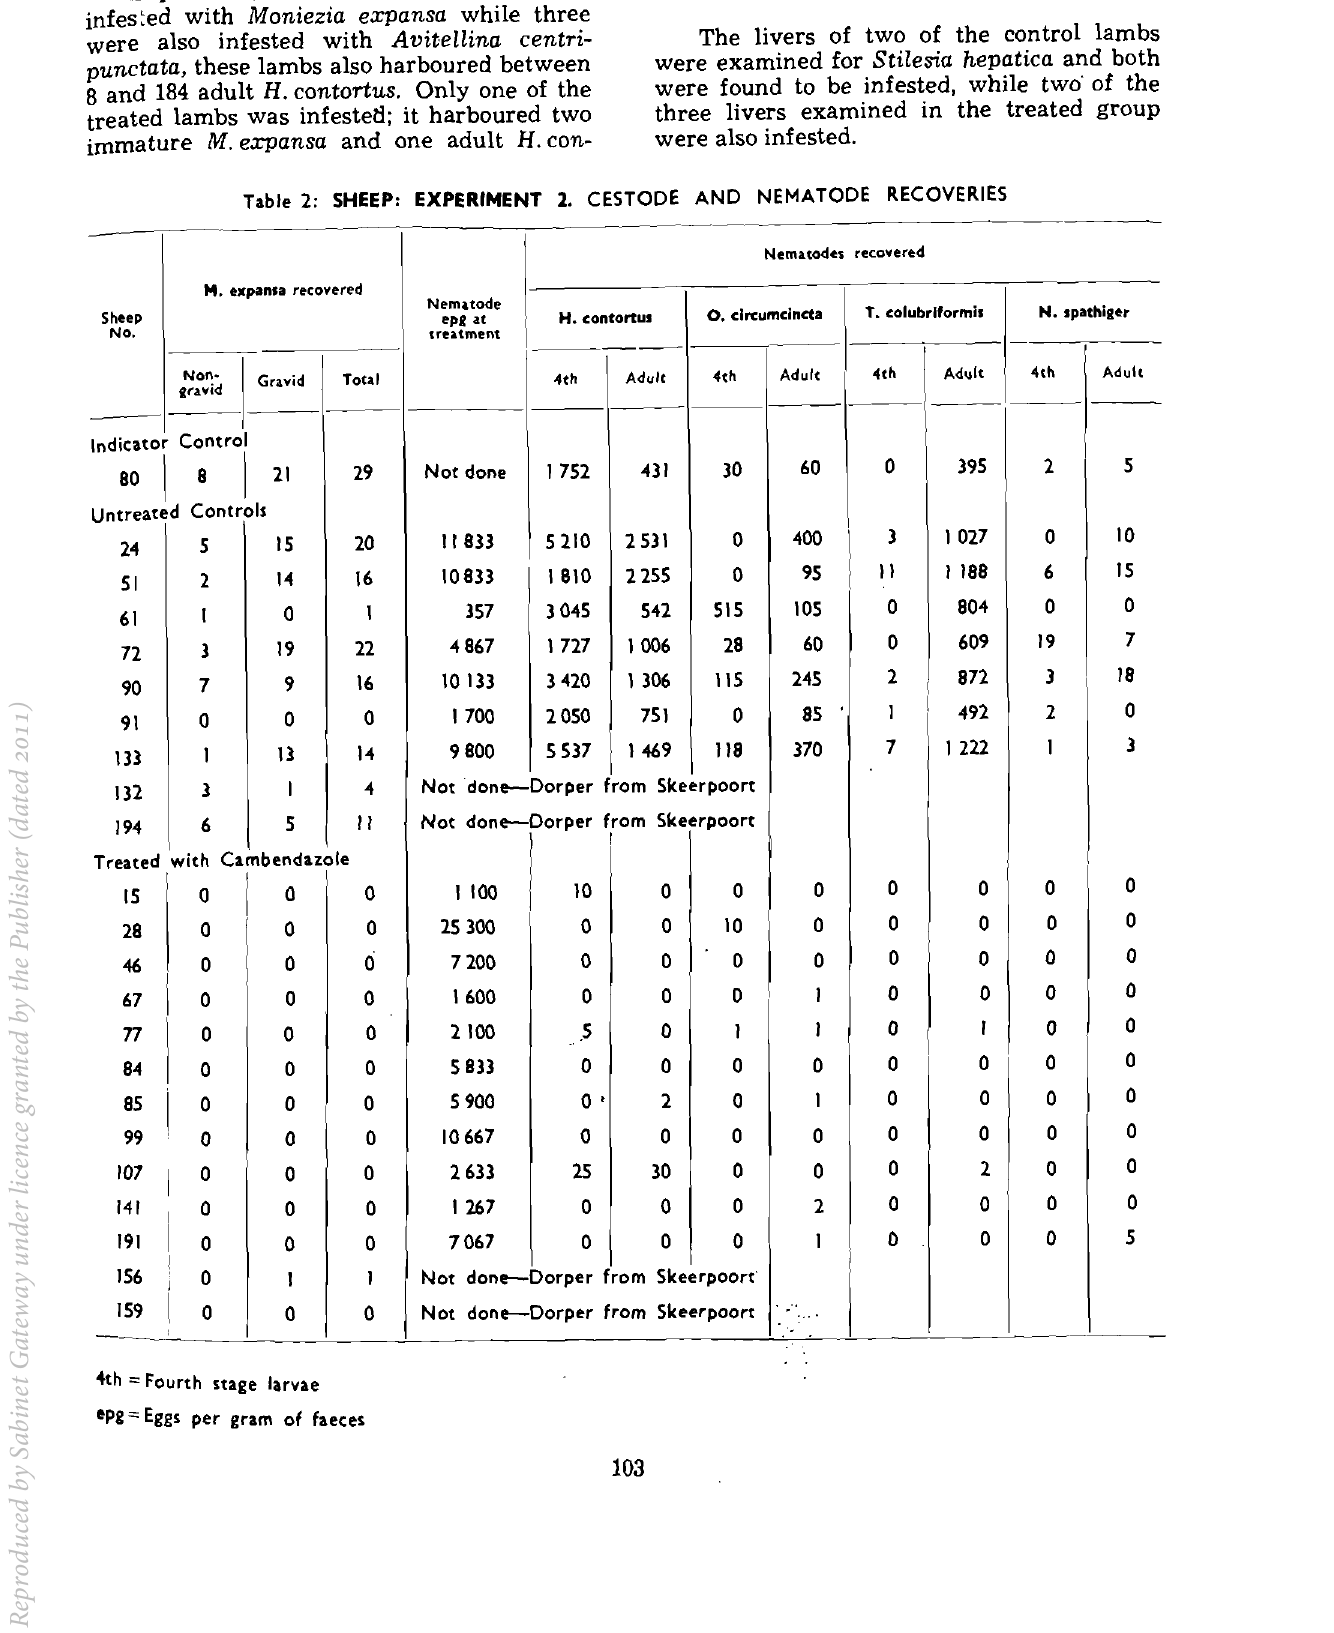
Table 2: SHEEP: EXPERIMENT 2. CESTODE AND NEMATODE RECOVERIES